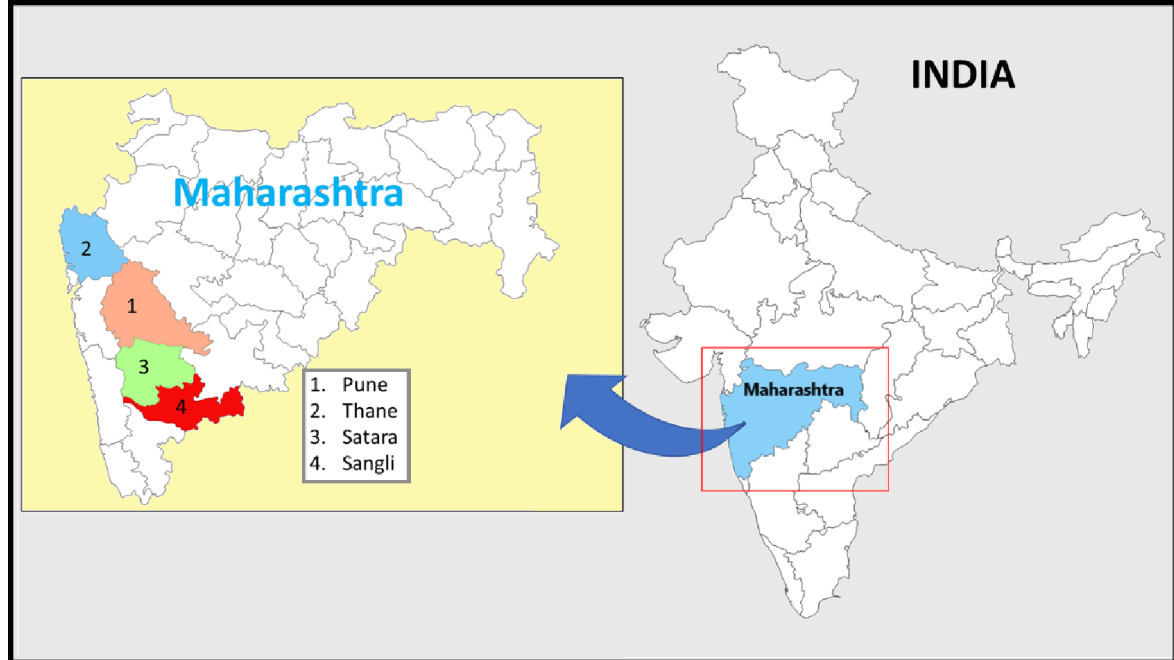
Fig 1. Maps of India showing the state of Maharashtra, and the four districts from which the outreach workers participated in group discussions.